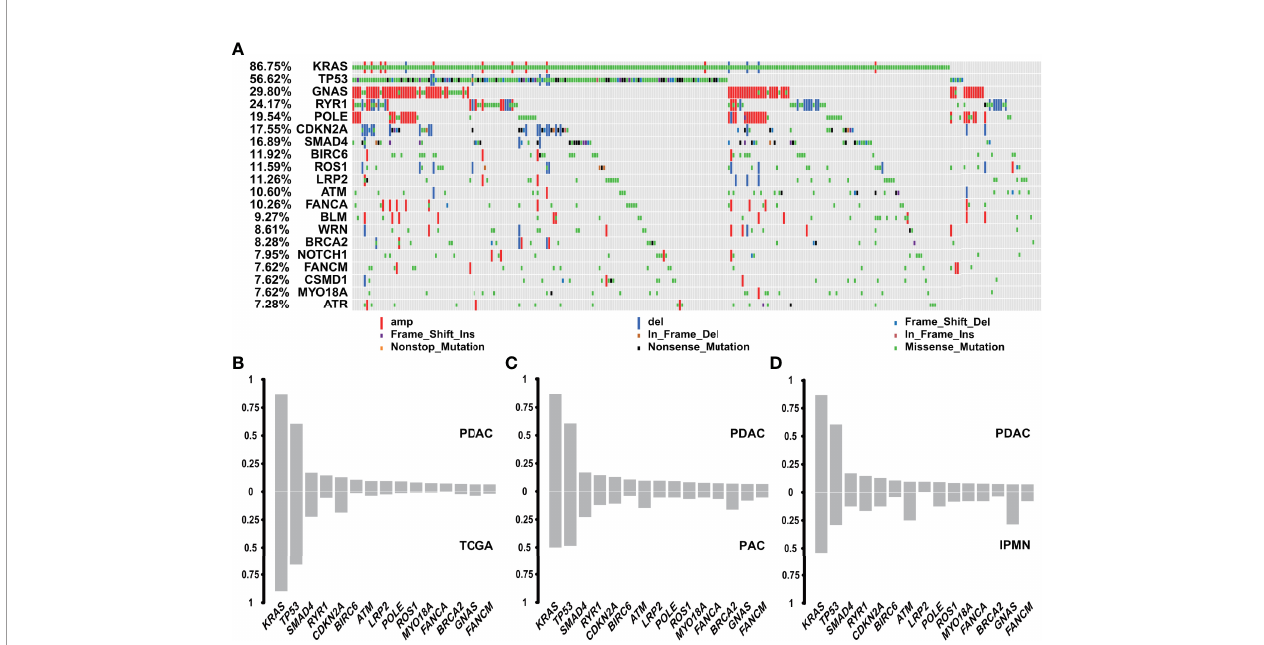
FIGURE 2 | Genomic landscape of genetic alterations in PDAC and comparison with other subtypes. (A) Genomic landscape of PDAC genetic alterations (n = 302). (B) Comparison between PDAC (n = 302) and TCGA database (QCMG, n = 383) in genetic mutations. (C) Comparison between PDAC (n = 302) and PVC (n = 74) in genetic mutations. (D) Comparison between PDAC (n = 302) and IPMN (n = 24) in genetic